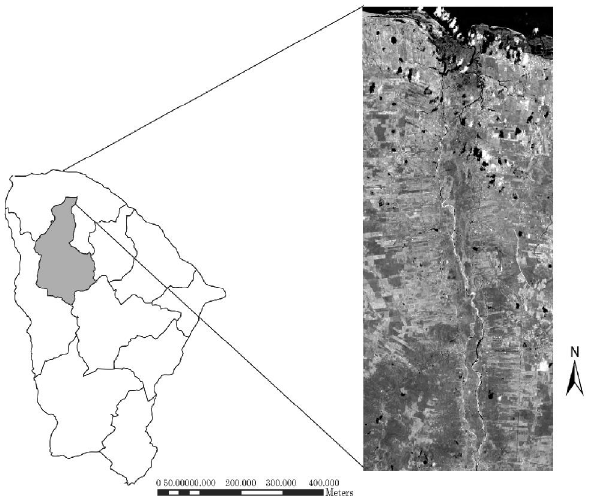
Figura 1. Representação do Estado do Ceará, com destaque para a área de estudo.